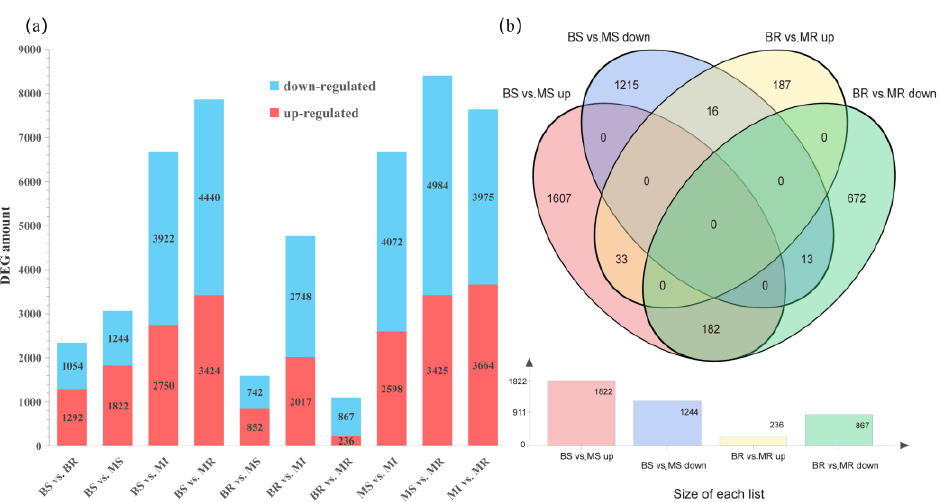
Figure 3. Analysis of DEGs. ( a ) Number of DEGs in each group. ( b ) Venn diagram analysis of DEGs